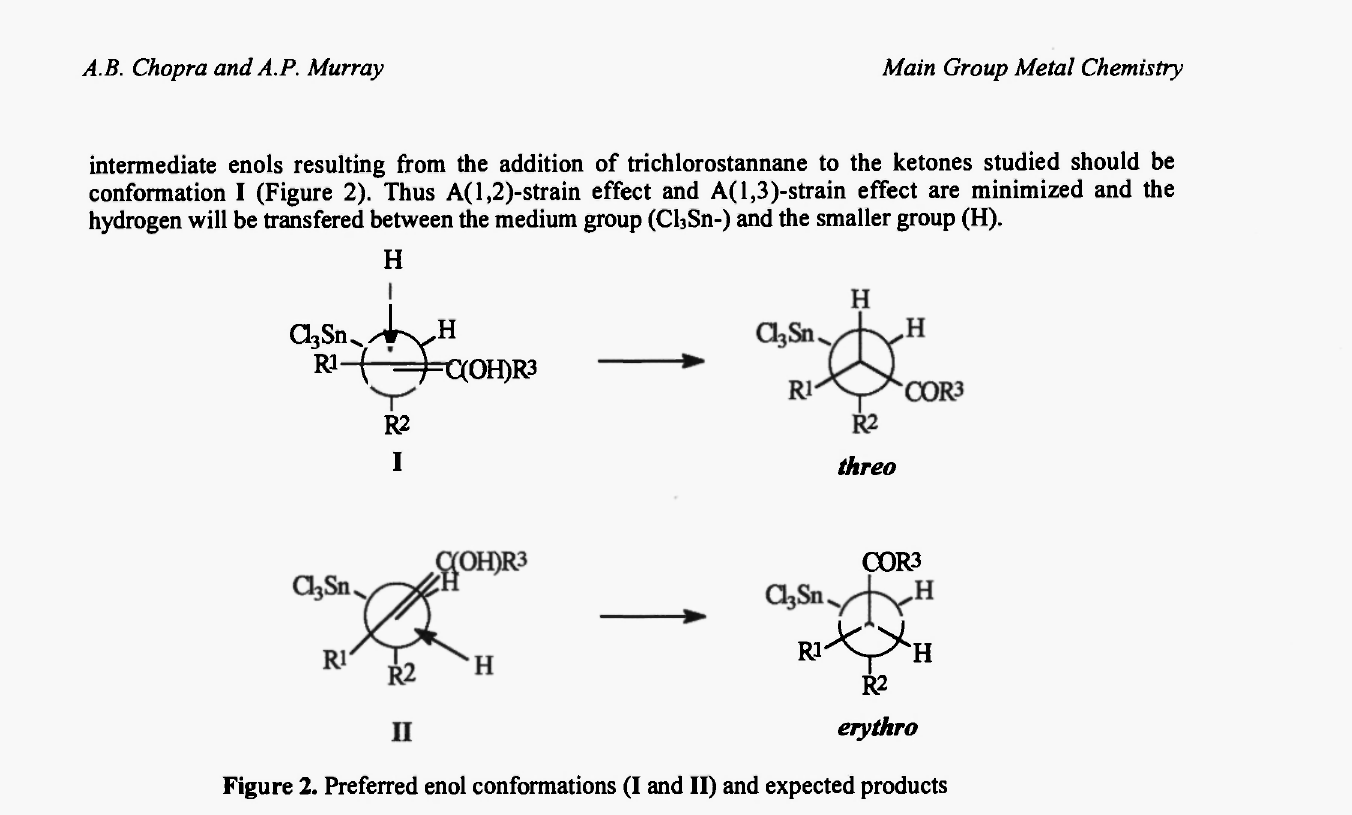
Figure 2. Preferred enol conformations (I and II) and expected